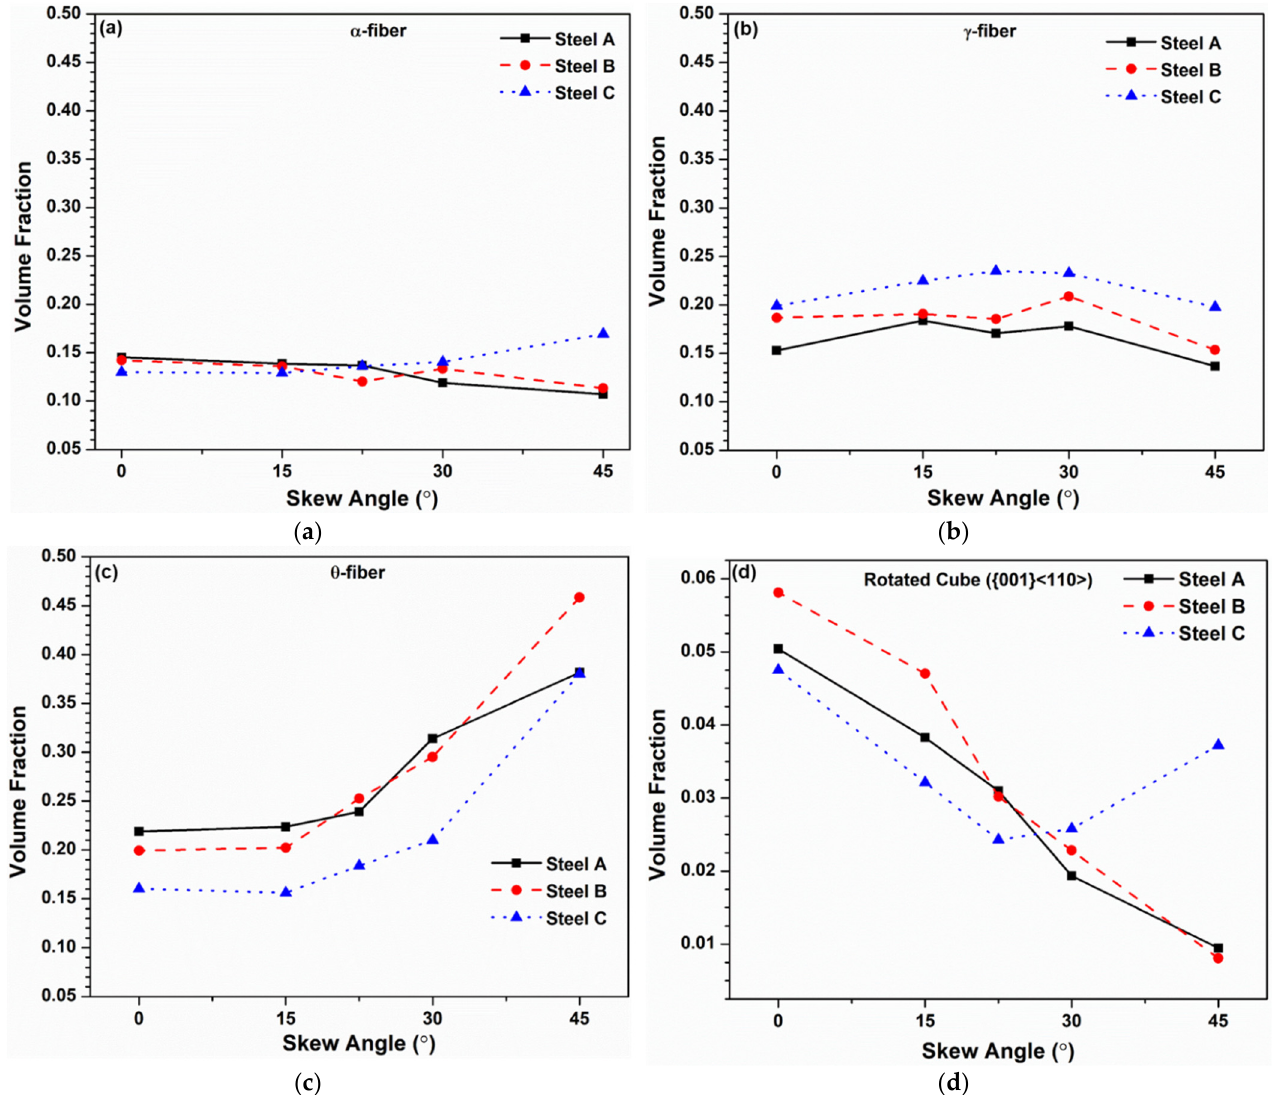
Figure 5. Comparison of the volume fractions of common texture fibers, ( a ) α -fiber, ( b ) γ -fiber, ( c ) θ -fiber and the rotated cube component ( d ), after skew cold rolling under unidirectional feeding. The effect of skew rolling on the rotated cube component (on the θ -fiber) is also